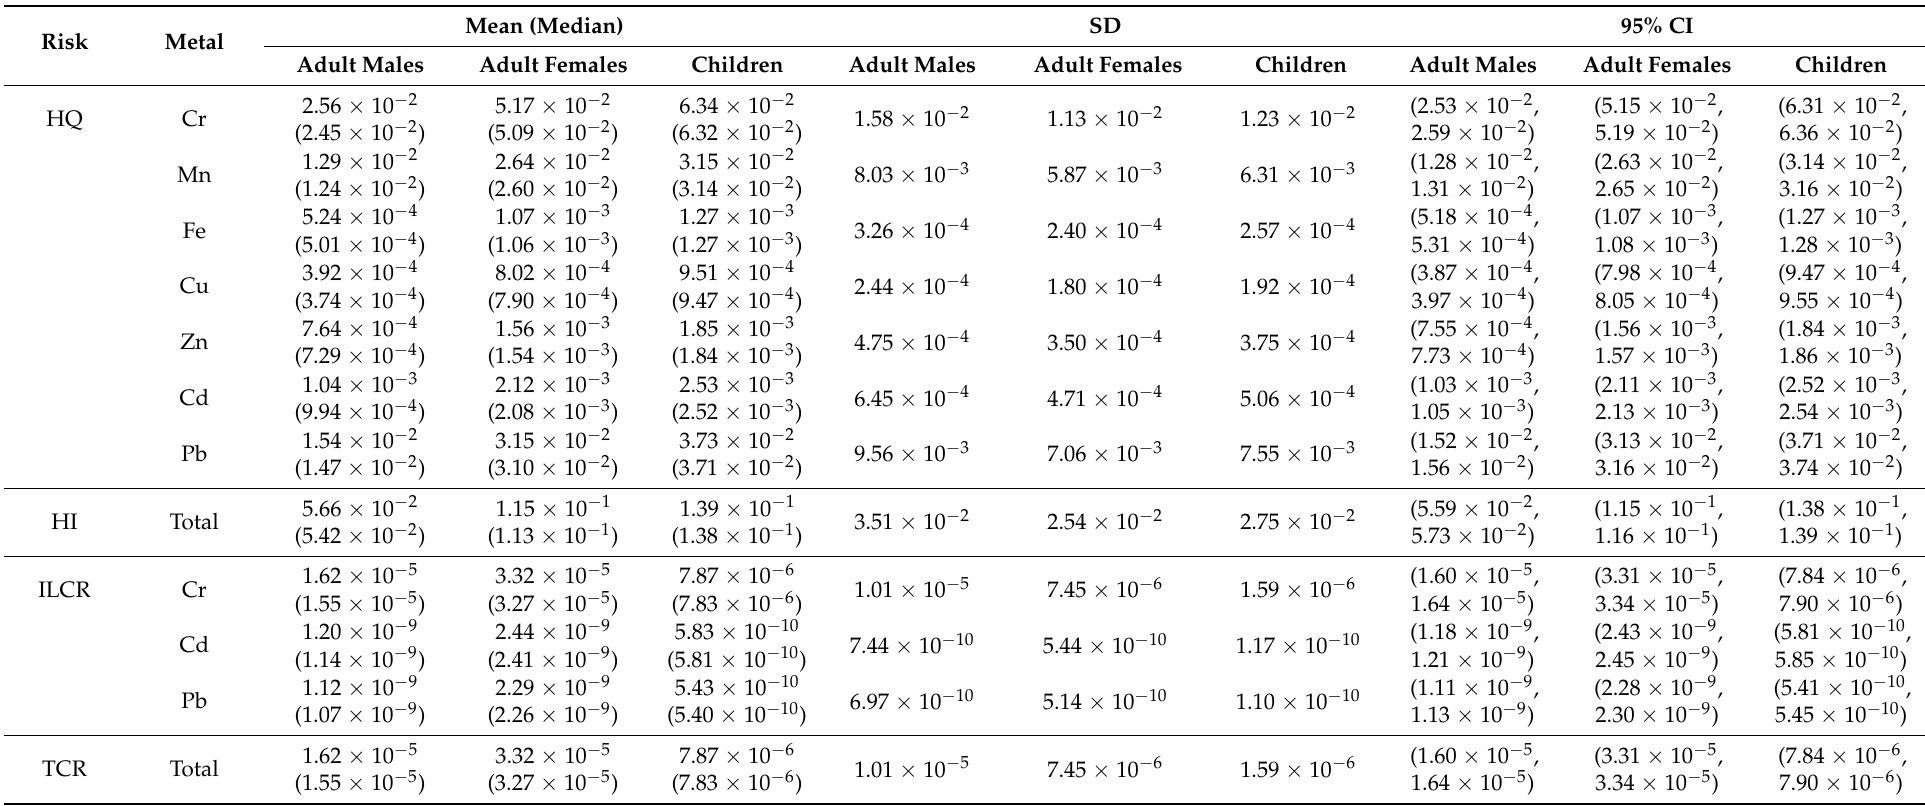
Table 2. Summary of statistics for non-carcinogenic and carcinogenic health risk results via Monte Carlo